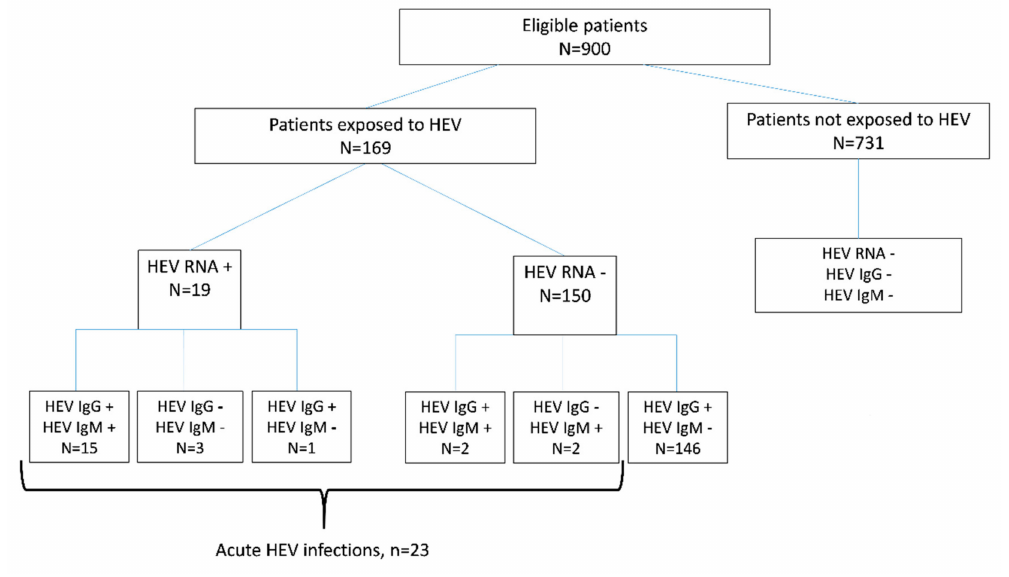
Figure 1. Study flow